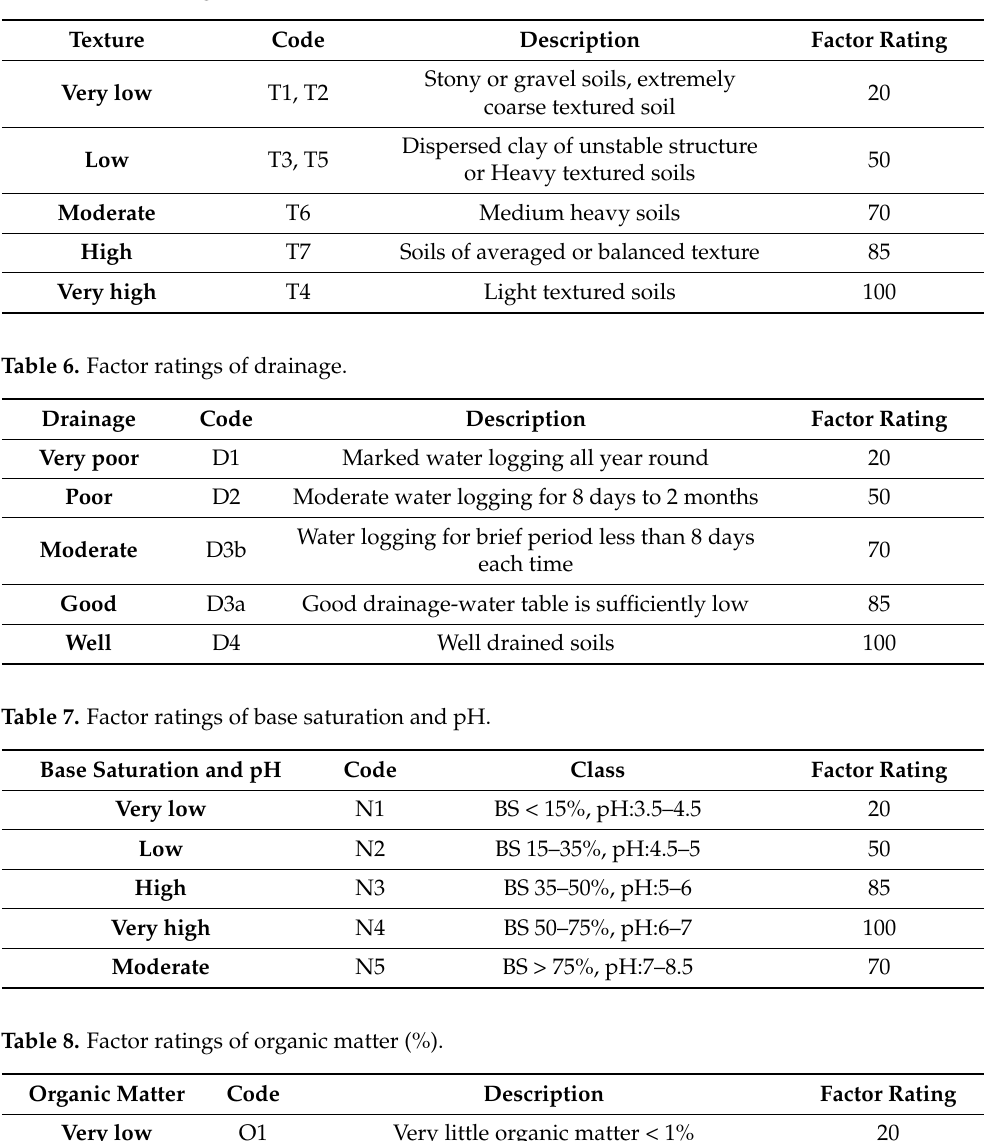
Table 5. Factor ratings of soil texture.